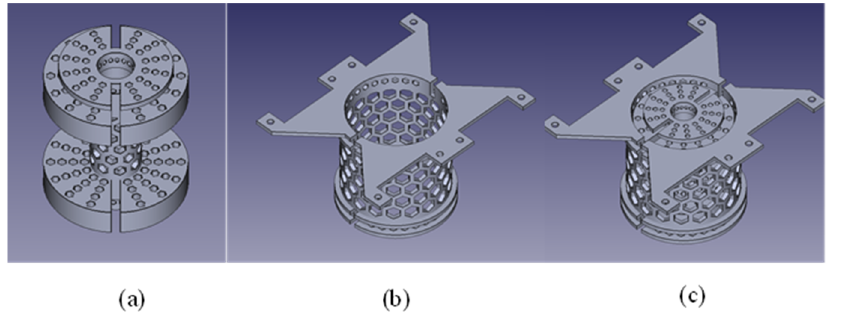
Figure 13. Model of transformer’s support: ( a ) Inside part A; ( b ) Outside part B; ( c ) Addition of both for total transformer support before winding. for total transformer support before